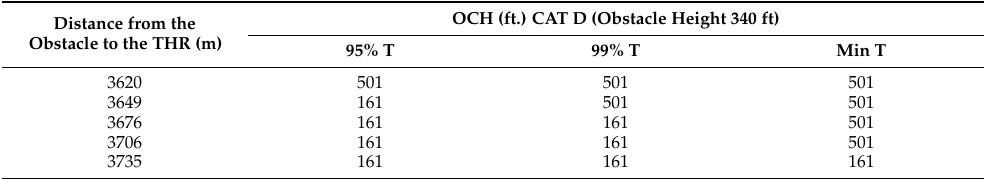
Table 11. OCH. Obstacles in different positions but at the same height.